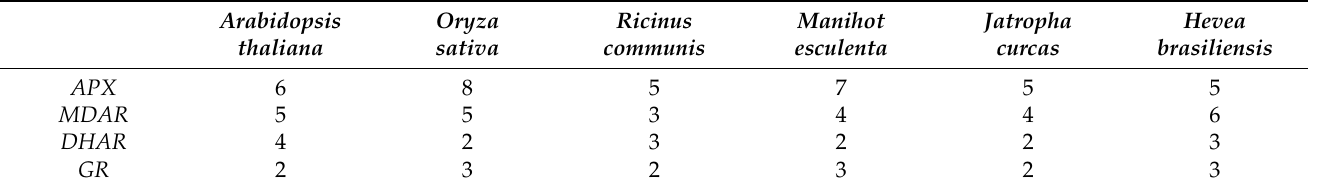
Table 1. Number of APX, MDAR, DHAR, and GR genes in Arabidopsis thaliana, Oryza sativa, Ricinus communis, Manihot esculenta, Jatropha curcas, and Hevea